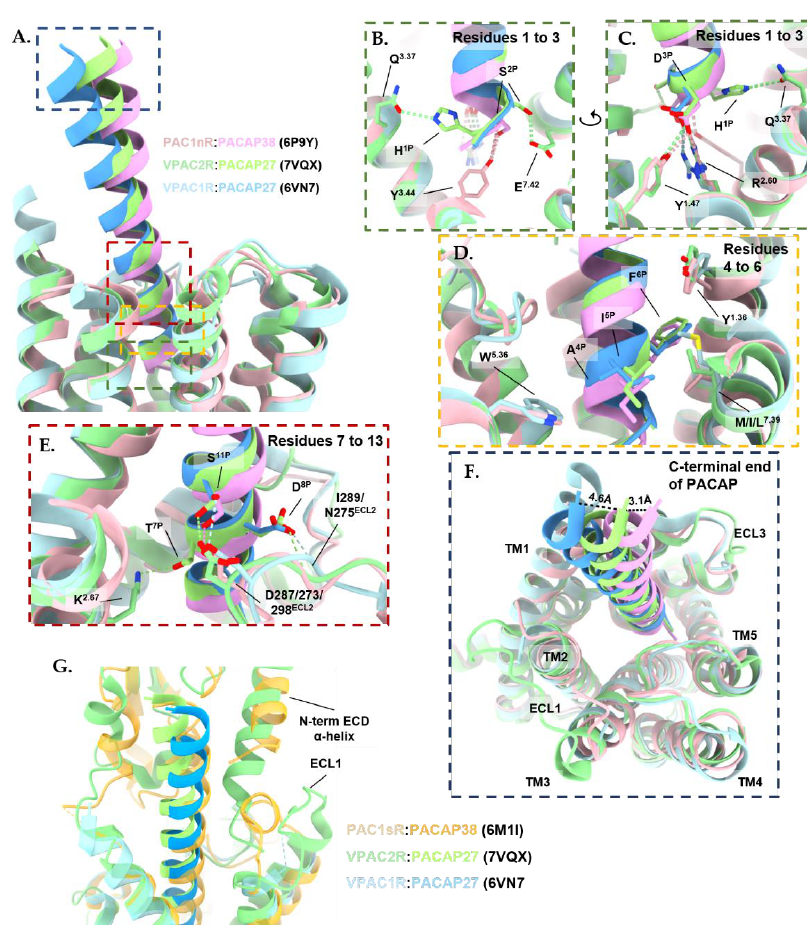
Figure 5. Comparison of PACAP in the binding pocket of VPAC1R (blue; PDB: 6VN7), VPAC2R (green; PDB: 7VQX) and PAC1nR (pink; PDB: 6P9Y). Structures were aligned by receptor chains and displayed as ribbons, with residues involved in hydrogen bonds (dotted lines) and hydrophobic interactions shown as a stick; calculated with ChimeraX 1.3 [310,311]. Extracellular domain (ECD) residues of the receptor were removed for clarity. Peptide residues are denoted with superscript P, extracellular loop residues are denoted as ECL. Receptor transmembrane (TM) residues are denoted using the Wootten numbering system. ( A ) Overview of comparison highlighting the regions of higher magnification displayed in panels ( B – E ) with matching colored dashed rectangles. ( B , C ) Close-up view of the hydrogen bonds formed between the first three residues of PACAP and the binding pocket of VPAC1R (blue), VPAC2R (green), and PAC1nR (pink). ( D ) Close-up view (front and back side view) of PACAP residues 4 to 6 that interact with conserved hydrophobic side chains in TM1 (Y 1.36 ), TM5 (W 5.36 ) and TM7 (M/I/L 7.39 ) of the peptide binding pocket of VPAC1R (blue), VPAC2R (green) and PAC1nR (pink). ( E ) Close-up view of hydrogen bonds formed between PACAP from residue 7 to 13 and the binding pocket of VPAC1R (blue), VPAC2R (green), and PAC1nR (pink). ( F ) Close-up view of the C-terminal end of PACAP peptide that is shifted 4.6 Å towards the receptor core in VPAC2R compared to VPAC1R, while the C-terminal end of PACAP peptide is shifted 3.1 Å towards ECL3 in PAC1R compared to VPAC2R. Distance between the α -carbon of Leu27P in PACAP peptide between the three structures calculated with ChimeraX 1.3. ( G ) The N-terminal α -helix of the VPAC2R ECD (green; PDB: 7VQX) adopts a unique conformation that deeply inserts into a cleft between PACAP27 and the predicted position of ECL1 in the model compared to the modeled ECD in the PACAP38-bound PAC1sR (yellow; PDB: 6M1I). Due to limited resolution in the N-terminal ECD and ECL1, these regions are not modeled in the PACAP27-bound VPAC1R structure (blue; PDB: